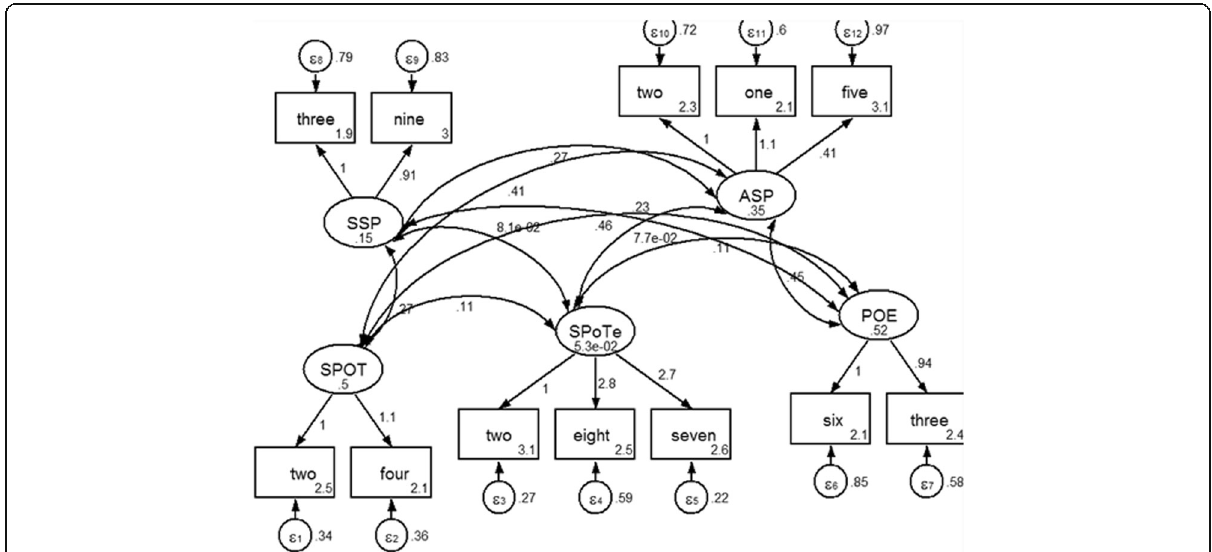
Fig. 1 Confirmatory factor analysis of DREEM-12 construct. SSP-Social Self Perception, ASP-Academic Self perception, SPOT-Students ’ Perception of Teachers, SPOTe-Students ’ Perception of Teaching, POE- Perception of Environment three-3, ninet-19, twone-21, fone-41, ffive-45, twtwo-22, ffour-44, two-2, eightn-18, tseven-37, tsix-36, fthree-43. LR test of model vs. saturated: chi2(44)=80.88, Prob > chi2 = 0.0006